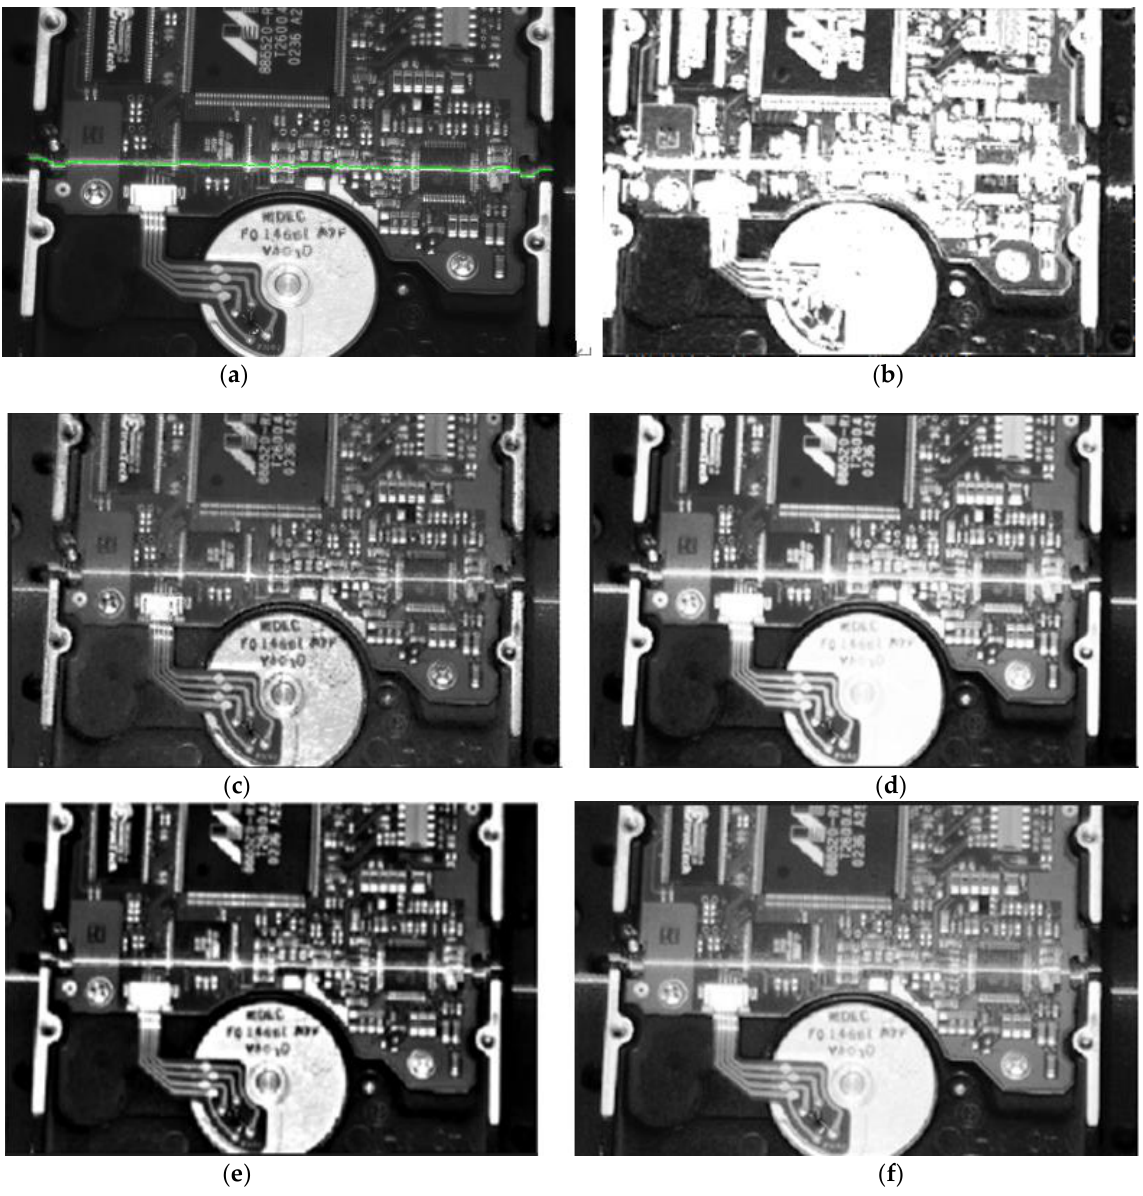
Figure 14. Comparison of different algorithms for PCB processing: ( a ) the algorithm of this paper; ( b ) ref. [24] algorithm; ( c ) ref. [25] algorithm; ( d ) ref. [26] algorithm; ( e ) ref. [27] algorithm; ( f ) ref. [28] algorithm.